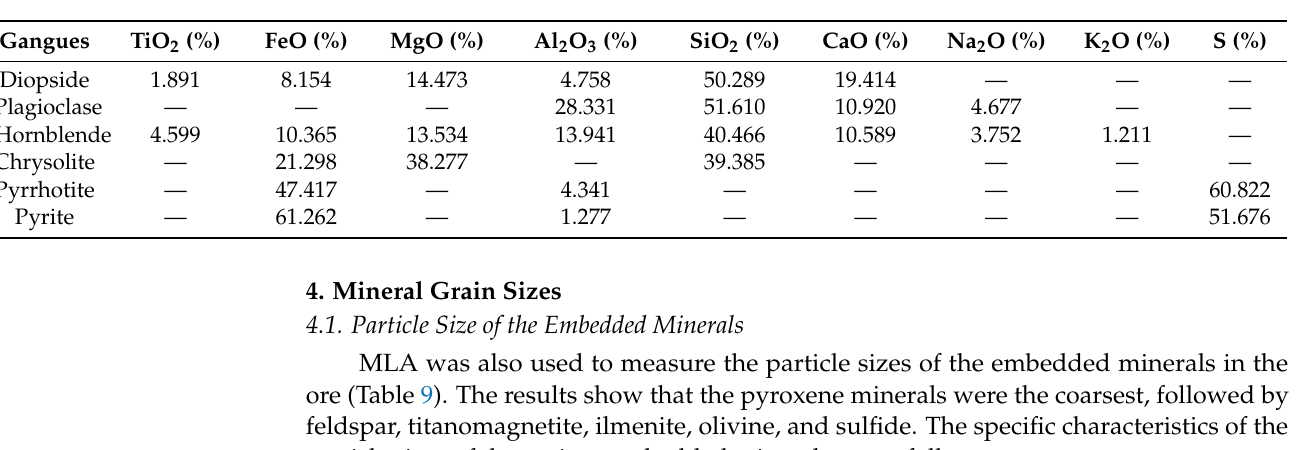
Table 8. Chemical composition of the different gangues present in the ore.